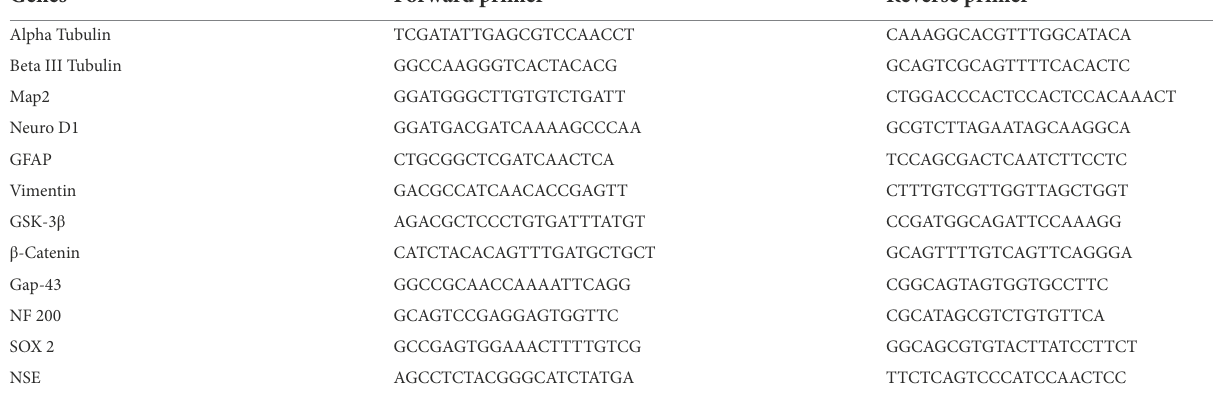
TABLE 1 Sequences of Primers used for